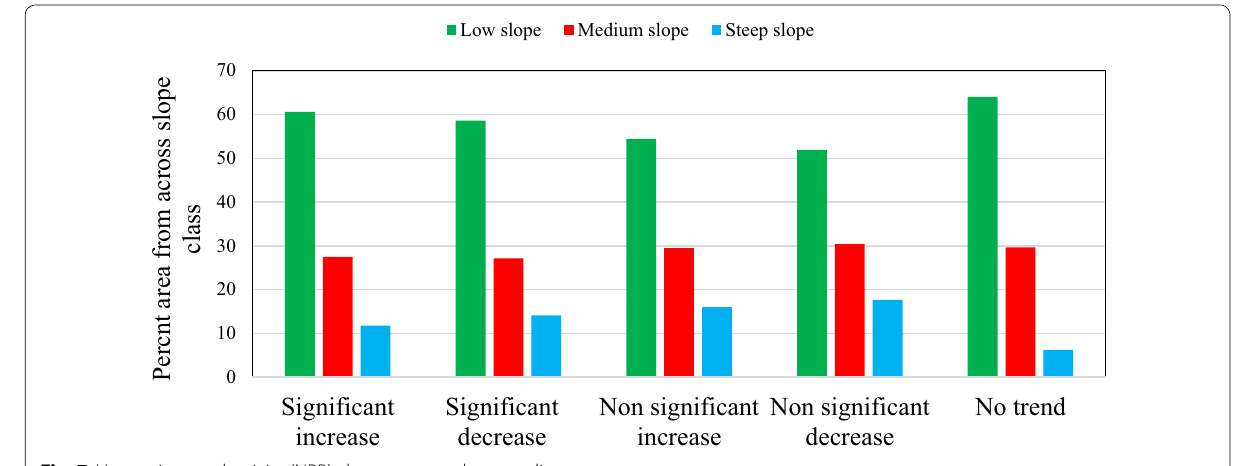
Fig. 7 Vegetation productivity (NPP) change across slope gradient